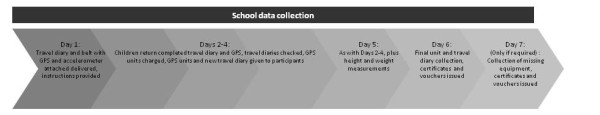
Overview of processes taken on school visit days. Note: GPS = Global Positioning System.